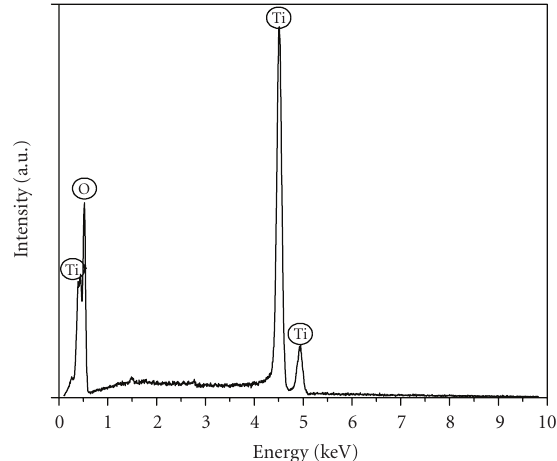
Figure 10: EDXS-spectrum of Degussa P25 prior to the photode- position of silver or the photodegradation of DCA.